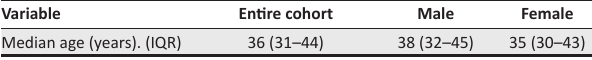
TABLE 1: Description of the median (interquartile range) age of study participants. Variable Entire cohort Male Female Median age (years). (IQR) IQR, interquartile